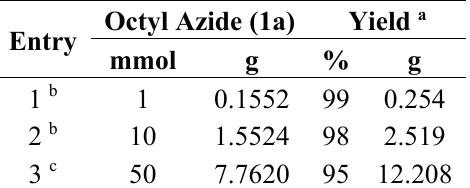
Table 2. Scale-up of mechanochemical